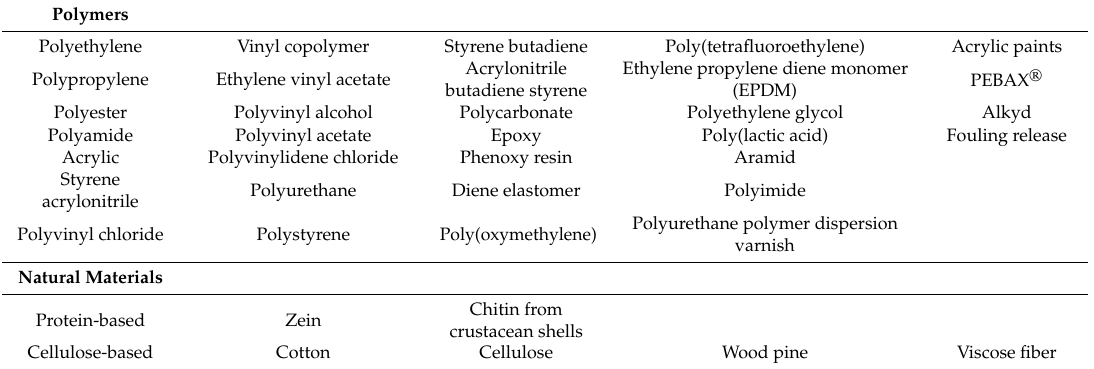
Table 1. List of polymer types and natural materials used as reference spectra, in automated MP